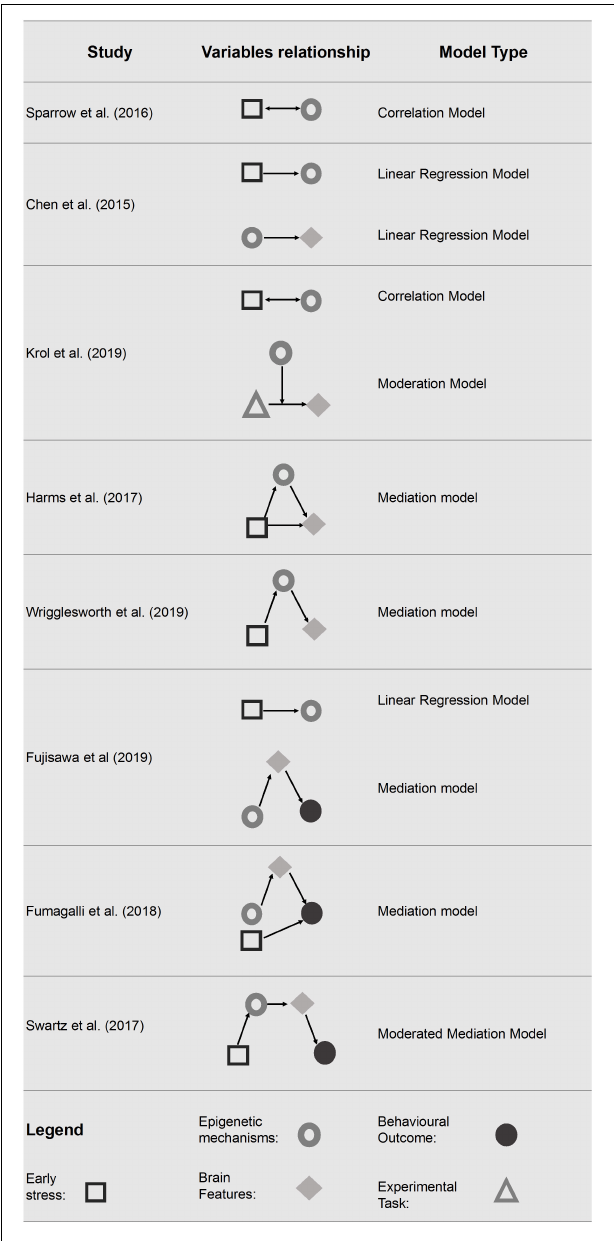
FIGURE 2 | Statistical models tested in the final pool of studies. Only significant associations are reported.